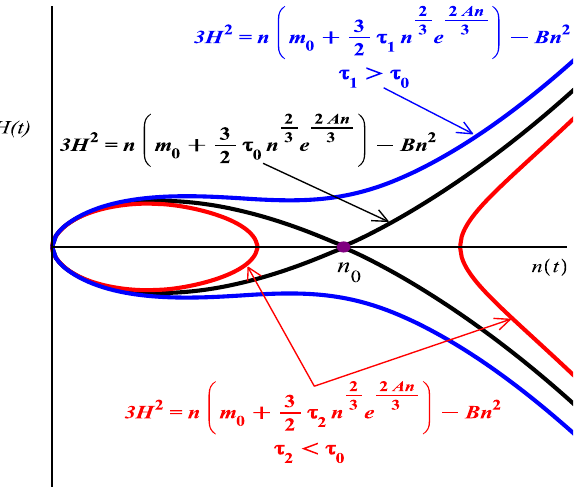
Fig. 1 The separatrix 3 H 2 − n [ m 0 + ( 3 / 2 )τ n 2 / 3 e 2 An / 3 ] + Bn 2 = 0 is an open curve when τ > τ 0 = 14 . 78 for a van der Waals gas with parameters A = 0 . 01 and B = 10 and m 0 , the typical mass of a representative particle, taken as 100. When τ < τ 0 , the separatrix has a loop at low n and an open part at high n . When τ > τ 0 , the trajectories to the right of the separatrix are those for dust component ρ d < 0, while those above or below it are with ρ d > 0. On the separatrix itself, ρ = 0. When τ < τ d 0 , the trajectories to the right of the open curve and those inside the loop are with ρ d < 0 while all others have ρ d > 0. (cid:12) The curve with τ = τ 0 is tangent to the abscissa at n 0 = 2 m 0 A + (cid:13) (cid:14) /( 4 AB ) = 73 . 59. The energy density A 2 + 20 m 0 AB + B 2 B + 4 m 2 0 + ( 3 / 2 )τ n 2 / 3 e 2 An / 3 ] − Bn 2 is positive for ρ [ n , T ( n ) ] = n [ m 0